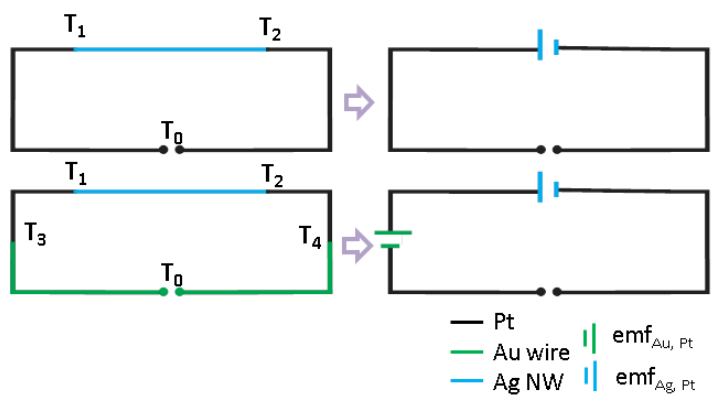
Figure 5. Different possible Seebeck interfaces in a gold wire-bonded TNCP. The thermally-induced electromotive force (emf) can occur in two metal joints in the case of a temperature